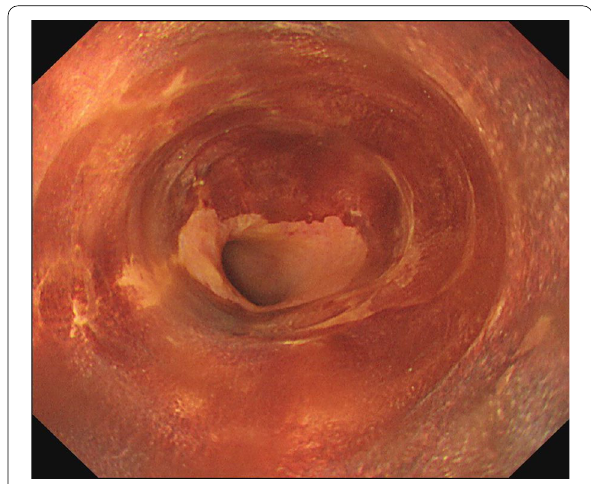
Fig. 6 Endoscopic findings after chemoradiotherapy for esophageal cancer treatment. Complete disappearance of the tumor was verified endoscopically. The unstained area remained after iodine staining, but malignant cells were not detected on